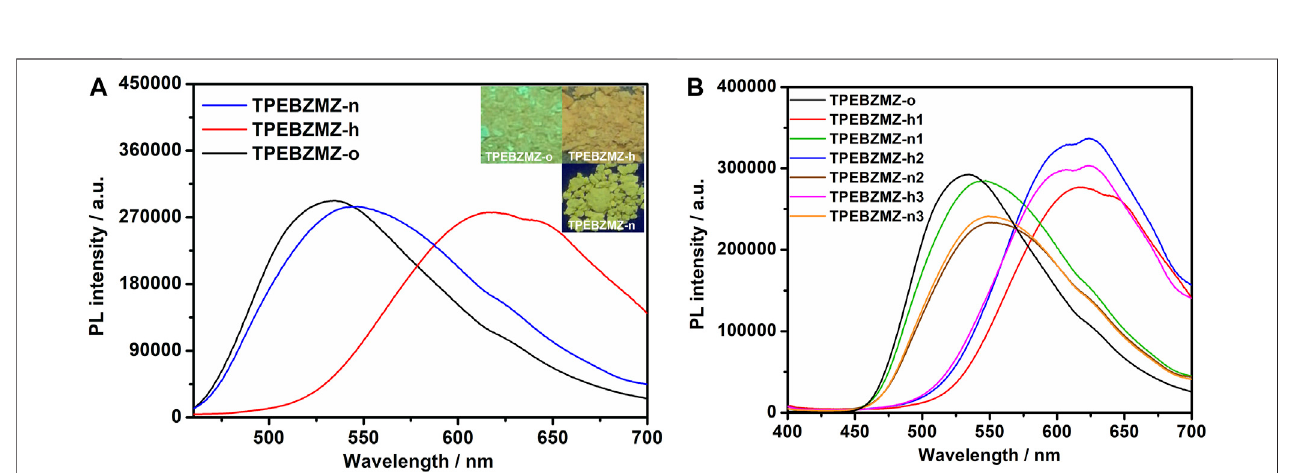
FIGURE 4 | (A) Fluorescence spectra and images of TPEBZMZ: TPEBZMZ-o, the original powder; TPEBZMZ-h, HCl-fumed (10 min) powder from TPEBZMZ-o (HCl gas was released from a 37% concentrated HCl aqueous solution); TPEBZMZ-n, NH 3 -fumed (15 min) powder from TPEBZMZ-o (NH 3 gas was released from